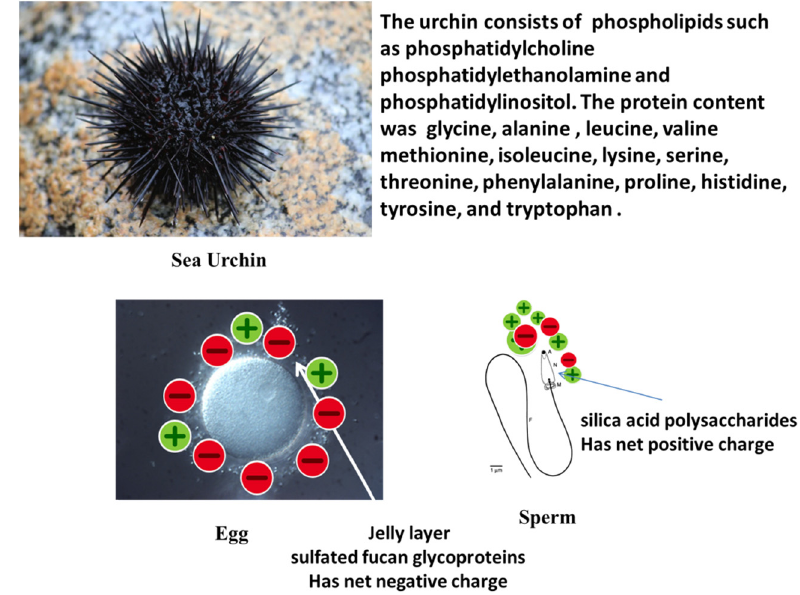
Figure 4: The interaction of egg and sperm of sea urchin taking place via the sperm